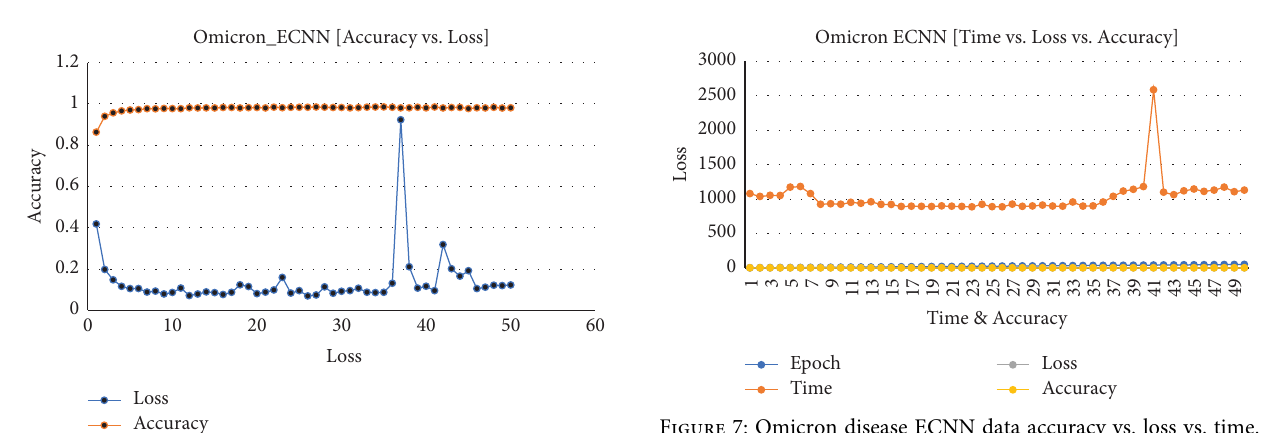
Figure 5: Omicron disease ECNN data accuracy vs. loss.